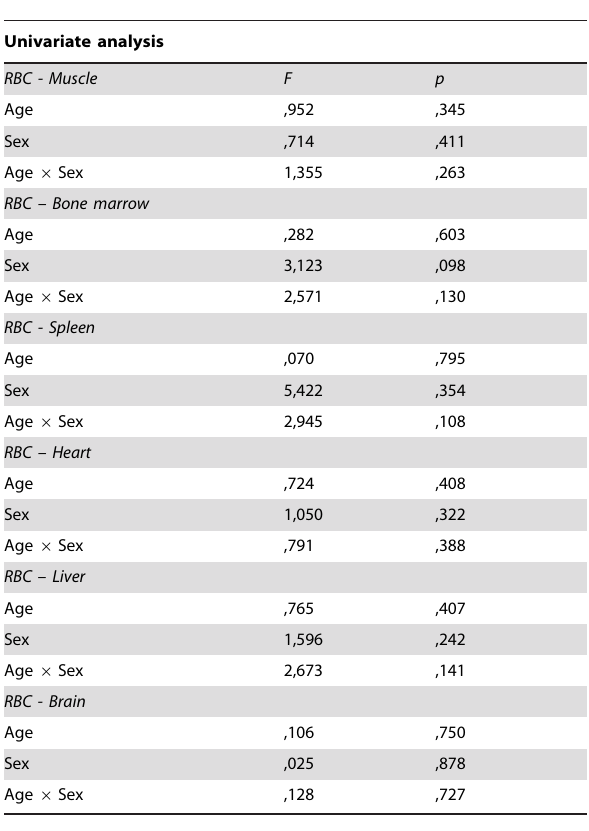
Table 3. Result of separate analyses of variance for the difference in red blood cells (RBC) and somatic tissues’ telomere length in relation to Sex, Age and the interaction Sex 6 Age.